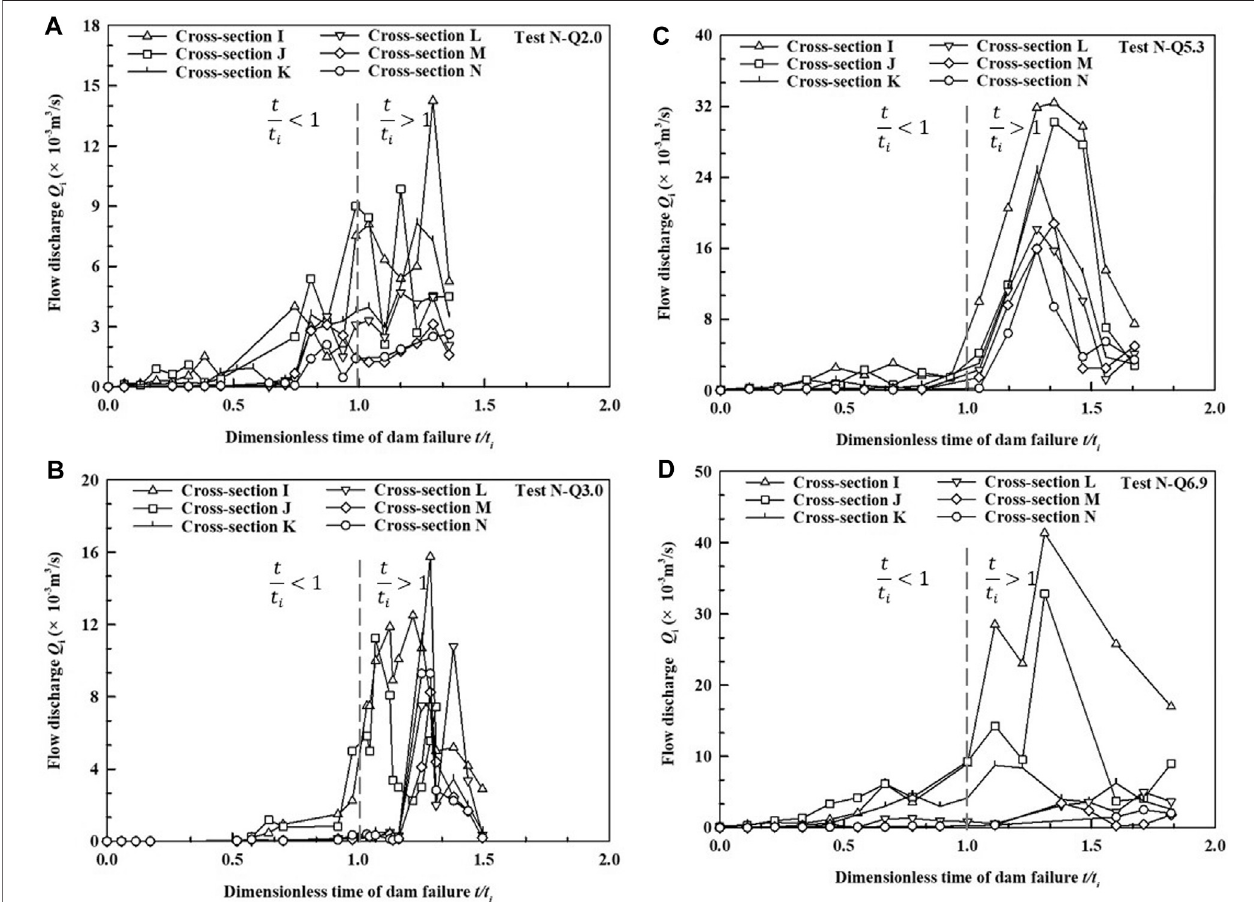
FIGURE 7 | Hydrographs of the dam-breaching fl ow discharge at different dam sections for different in fl ow discharges (A) Q in (cid:2) 2.0 × 10 − 3 m 3 /s (B) Q in (cid:2) 3.0 × 10 − 3 m 3 /s (C) Q in (cid:2) 5.3 × 10 − 3 m 3 /s (D) Q in (cid:2) 6.9 × 10 − 3 m 3 /s.